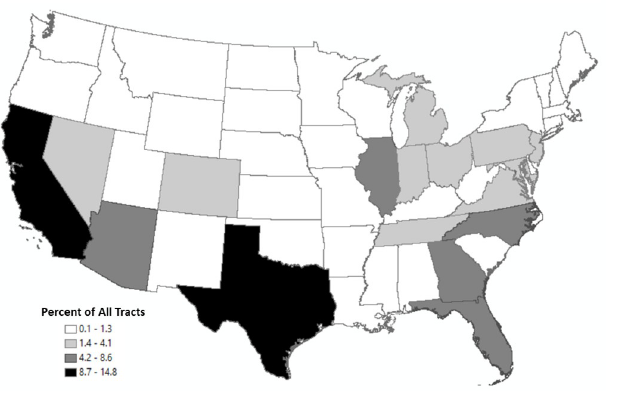
Fig 2. Distribution of tracts outside margin of uncertainty.